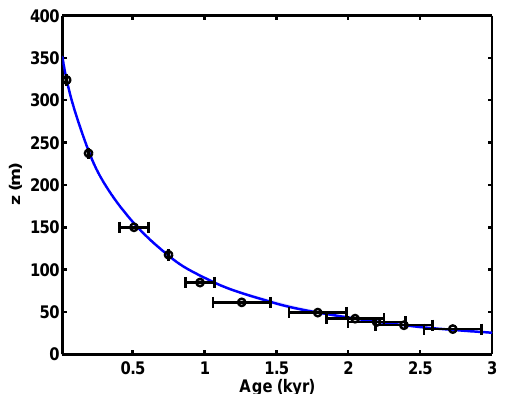
Figure 5. Recovered accumulation (blue) from James Ross ice core observed age–depth and stable water isotope δD (black). Red symbols represent the uncertainty in age-depth at the points where absolute markers were found (Mulvaney et al., 2012). The area in blue represents uncertainty in recovered accumulation due to unknown ice-flow parameter n (2 ≤ n ≤ 5 ). The stable water isotope δD has not been used for the inversion and is plotted only for